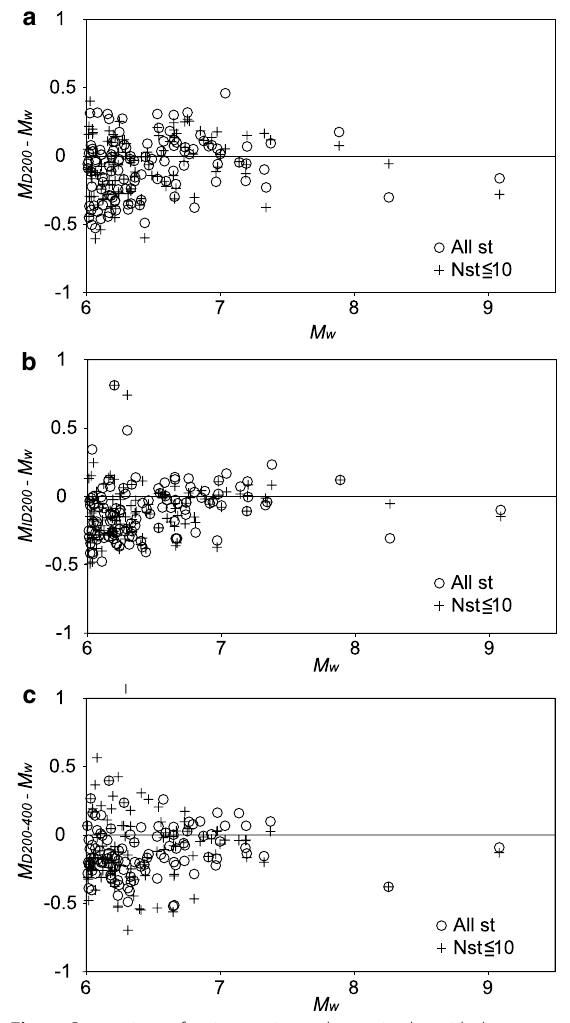
Fig. 5 Comparison of various estimated magnitudes with the moment magnitude ( M w ). a Comparison between the magnitude based on highpass-filtered (200 s cutoff) displacement ( M D 200 ) and M w . b Comparison between the magnitude based on integrated displacement (200 s cutoff, M ID 200 ) and M w . c Comparison between the magnitude based on bandpass-filtered (200–400 s) displacement ( M D 200 −− 400 ) and M